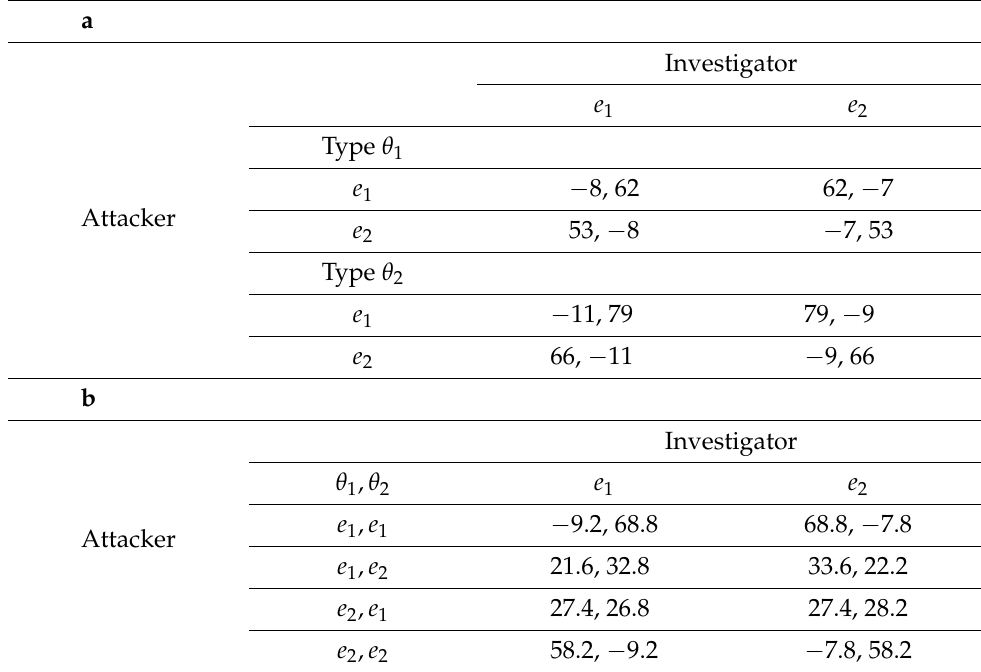
Table 3. Illustrative example of BCFG. ( a ) Payoffs table for BCFG before transformation, ( b ) Payoff table after Harsanyi